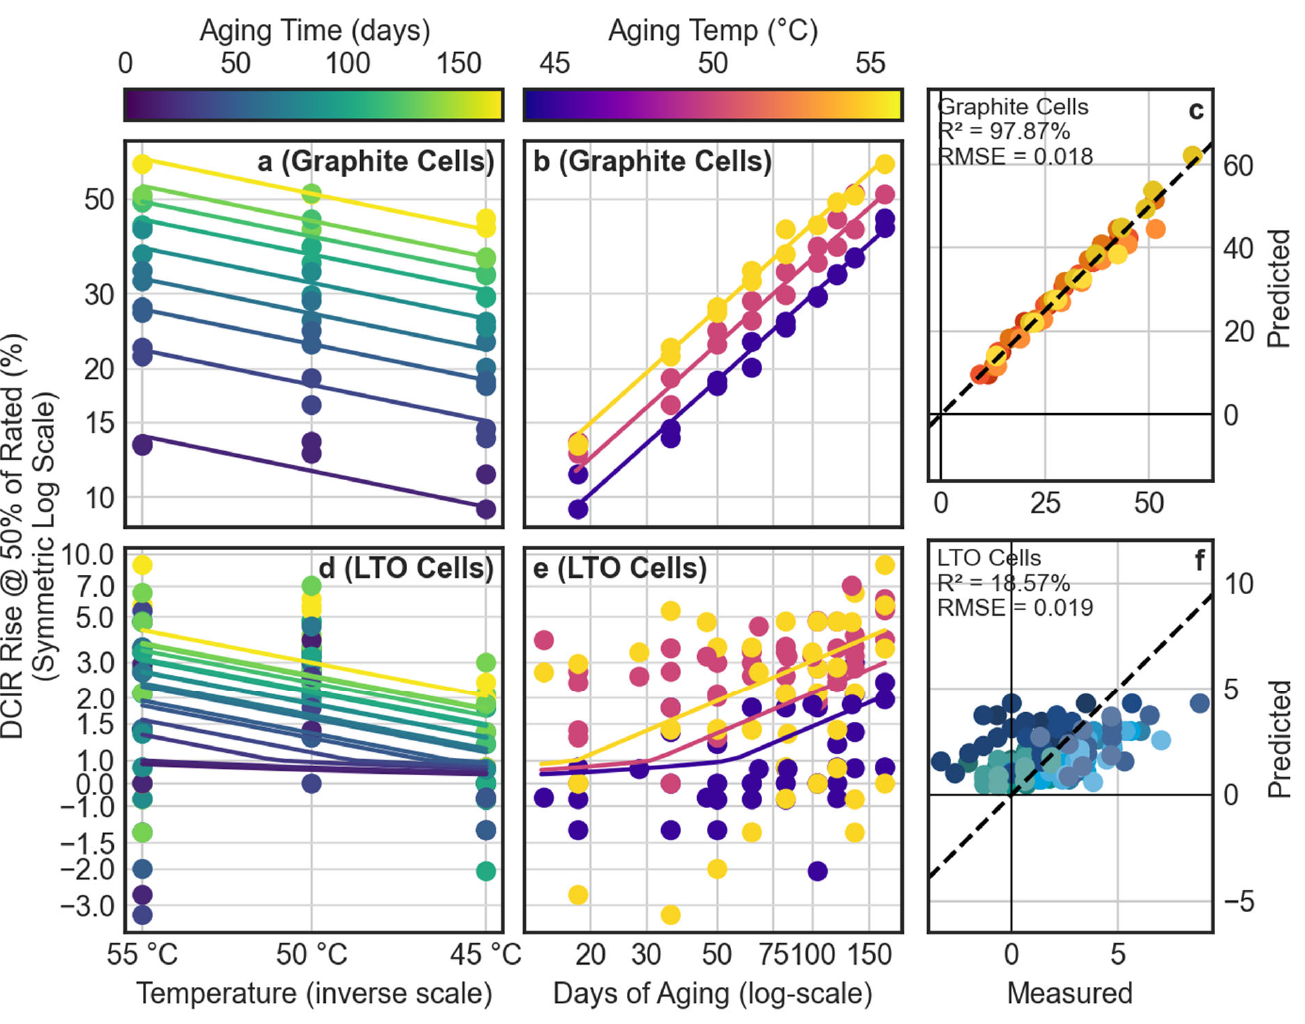
Figure 12. Quality of fit metrics for the modified Arrhenius fit of the DCIR at 50%. Upper plots ( a – c ): the graphite cells. Lower plots ( d – f ): the LTO cells. Left column ( a , d ): the rise in DCIR (symmetric log scale) vs. aging temperature (plotted on an inverse absolute temperature scale), with colors indicating aging time. Middle column ( b , e ): the rise in DCIR vs. aging time, with colors indicating aging temperature. The points indicate measured data, while the lines reflect the best fit for the model. Right column ( c , f ): the predicted vs. the actual results. Colors reflect the individual cells; the 45° line indicates a perfect agreement between the model and the data.